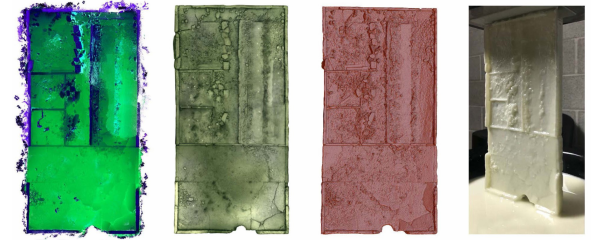
Figure 9. Image Based Models of The Cambell’s Barn